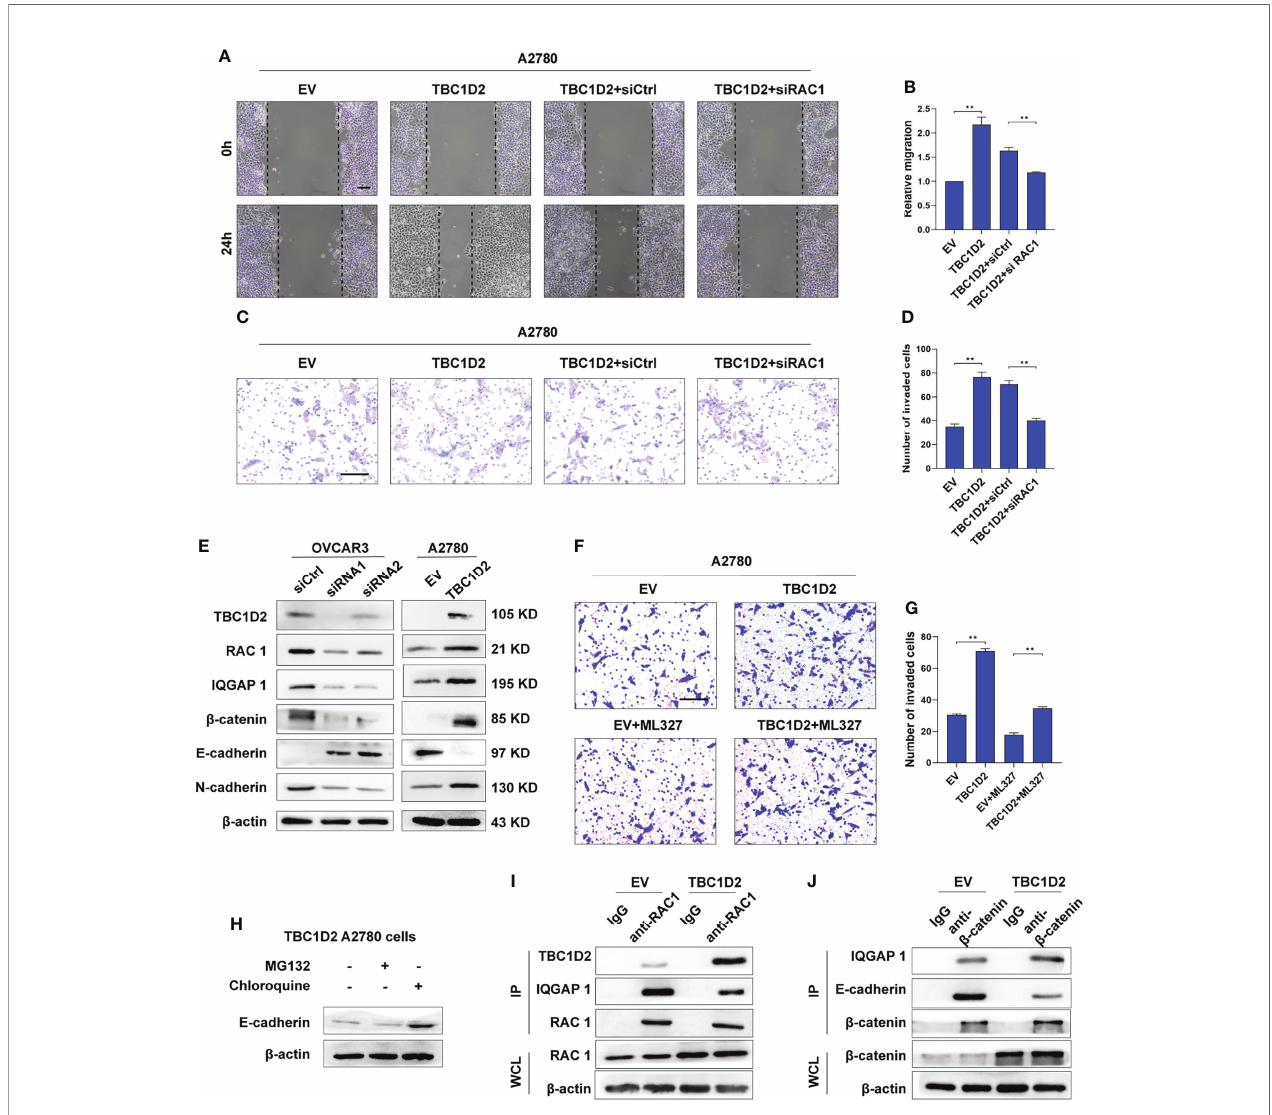
FIGURE 5 | TBC1D2 promotes cell invasion by decreasing E-cadherin via disassembling Rac1-IQGAP1 complex. (A-D) Representative images and analysis of wound healing assay and transwell invasion assay in A2780 cells treated as indicated. EV, empty vector; TBC1D2, overexpression vector encoding TBC1D2; siCtrl, control siRNA; siRac1, siRNA against Rac1. Scale bars, 100 m m (E) Western blotting images of TBC1D2, Rac1, IQGAP1, b -catenin, E-cadherin, N-cadherin and b - actin in OVCAR3 and A2780 cells treated as indicated. siRNA1 or siRNA2, siRNA against TBC1D2; siCtrl, control siRNA; EV, empty vector; TBC1D2, overexpression vector encoding TBC1D2. (F, G) Representative images and analysis of transwell invasion assay in A2780 cells treated as indicated. EV, empty vector; TBC1D2, overexpression vector encoding TBC1D2. Scale bars, 100 m m (H) Western blotting images of E-cadherin and b -actin in TBC1D2 overexpressed A2780 cells treated with MG132 or Chloroquine. (I) Co-IP of anti-Rac1 with TBC1D2 or IQGAP1 from A2780 cells treated as indicated. Equal amount of immunoprecipitated Rac1 from TBC1D2 overexpressed or control A2780 cells was loaded in WB assay. WCL, whole cell lysates. (J) Co-IP of anti- b -catenin with IQGAP1 or E-cadherin from A2780 cells treated as indicated. Equal amount of immunoprecipitated b -catenin from TBC1D2 overexpressed or control A2780 cells was loaded in WB assay. WCL, whole cell lysates. Two-tailed Student ’ s t tests were used to determine the signi fi cance of differences between two groups; data are represented as mean ± SEM.